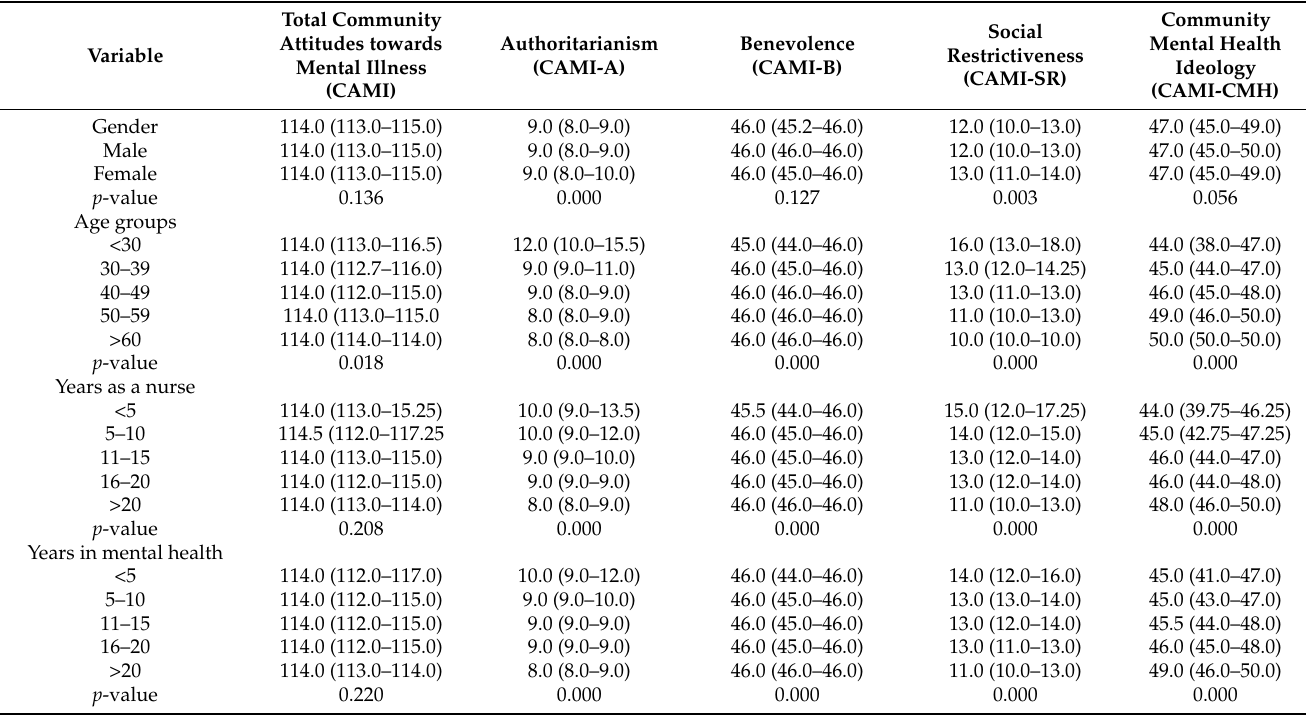
Table 5. Association between attitudes towards mental health patients and sociodemographic